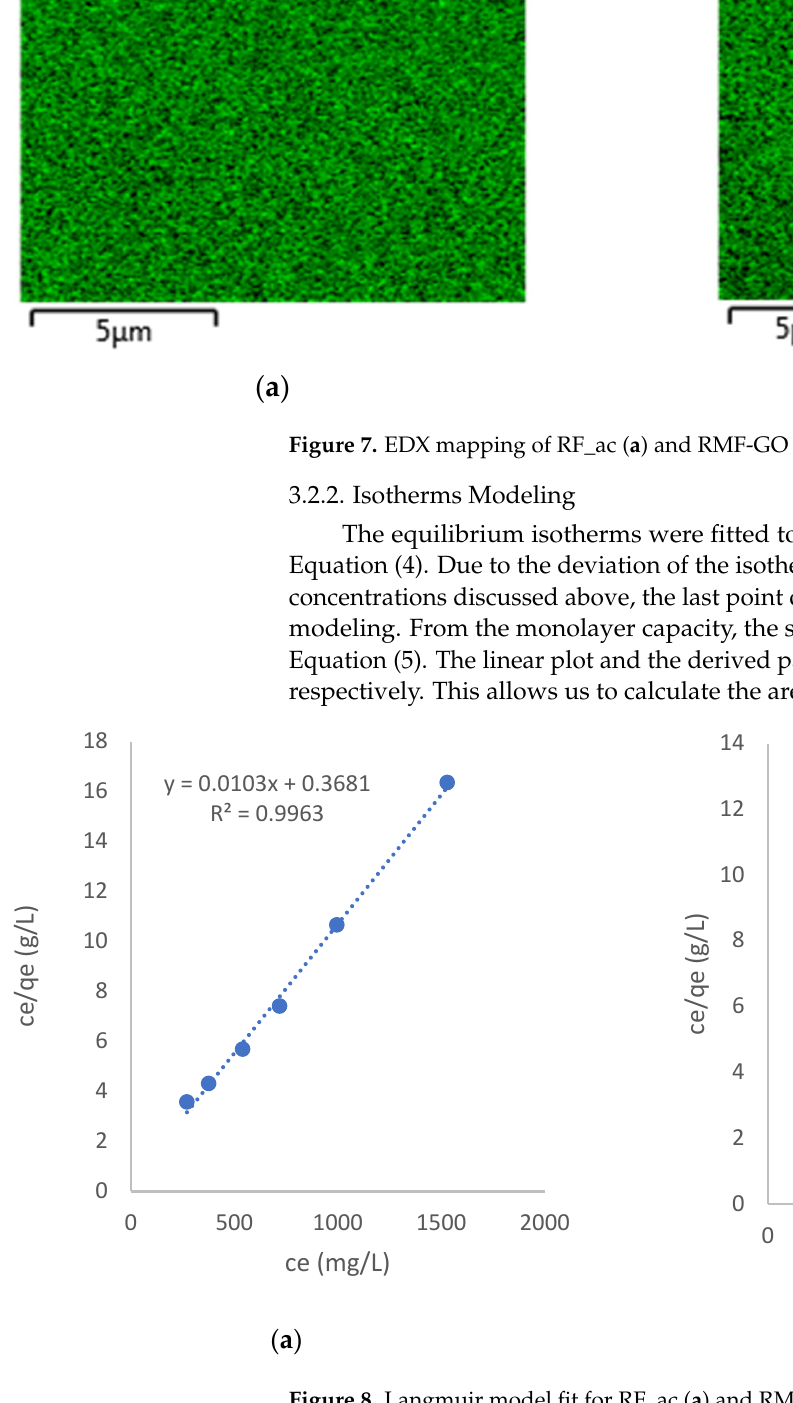
Figure 8. Langmuir model fit for RF_ac ( a ) and RMF-GO ( b ).